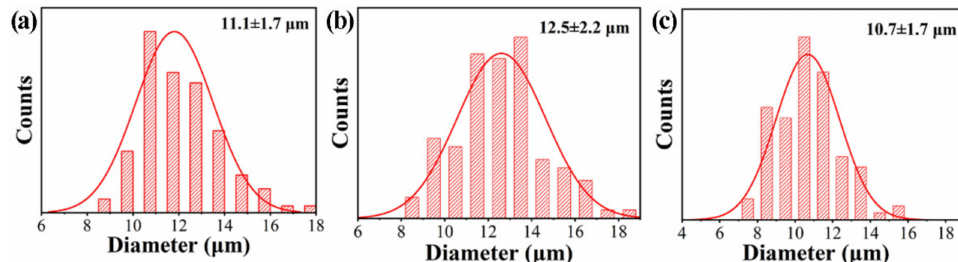
Figure 9. Histograms of size distribution for oil droplets in different oil-in-water emulsions: ( a ) n-hexane/water, ( b ) n-dodecane/water and ( c ) n-hexadecane/water before